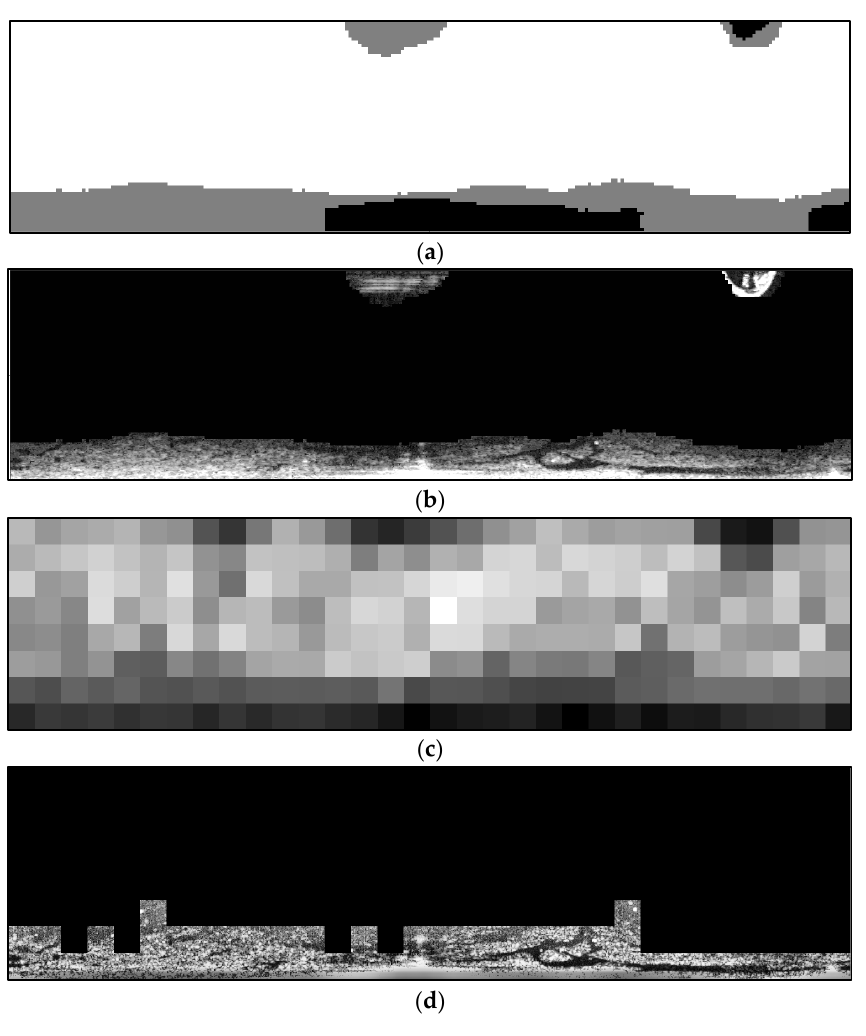
Figure 17. The effective monitoring region extraction with texture features and machine learning. ( a ) LBP feature and K-means classification result: The sliding window size was 128 × 128, the classi- fication number is 3; ( b ) The effective monitoring region extraction with LBP feature and K-means; ( c ) Contrast feature of GLCM: The tile window size was 64 × 64; ( d ) The effective monitoring region extraction with GLCM and SVM.